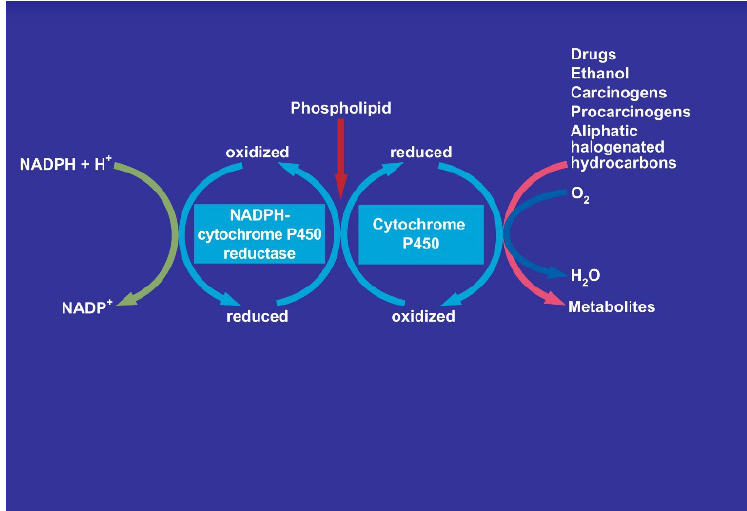
Figure 20. Involvement of cytochrome P450 in the microsomal metabolism of various substrates including aliphatic halogenated hydrocarbons with carbon tetrachloride as example. The NADPH-cytochrome P450 uses NADPH + H + and will itself be reduced, allowing the cytochrome P450 to be transferred from the oxidized state to the reduced state. The overall reactions needs also molecular oxygen and phospholipids. Toxics 2018 , 6 , x FOR PEER REVIEW